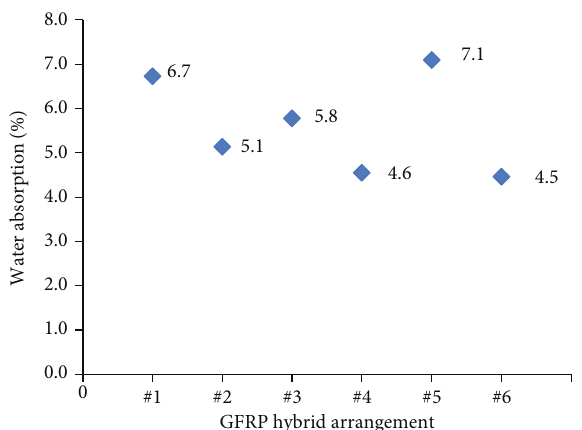
Figure 9: Water absorption of three single type fibre.